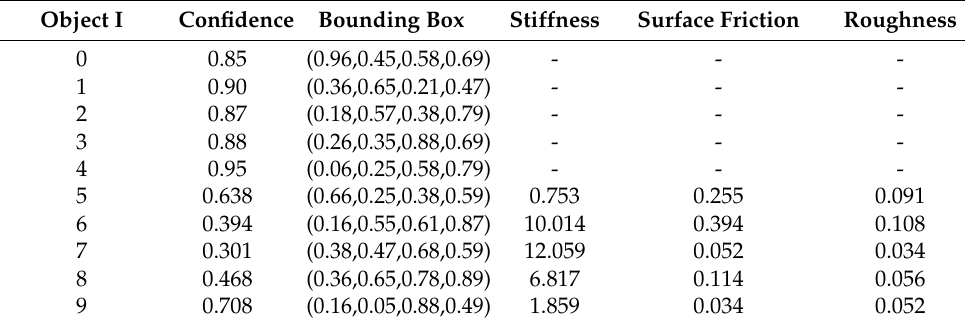
Table 1. Sample example of feature values for each